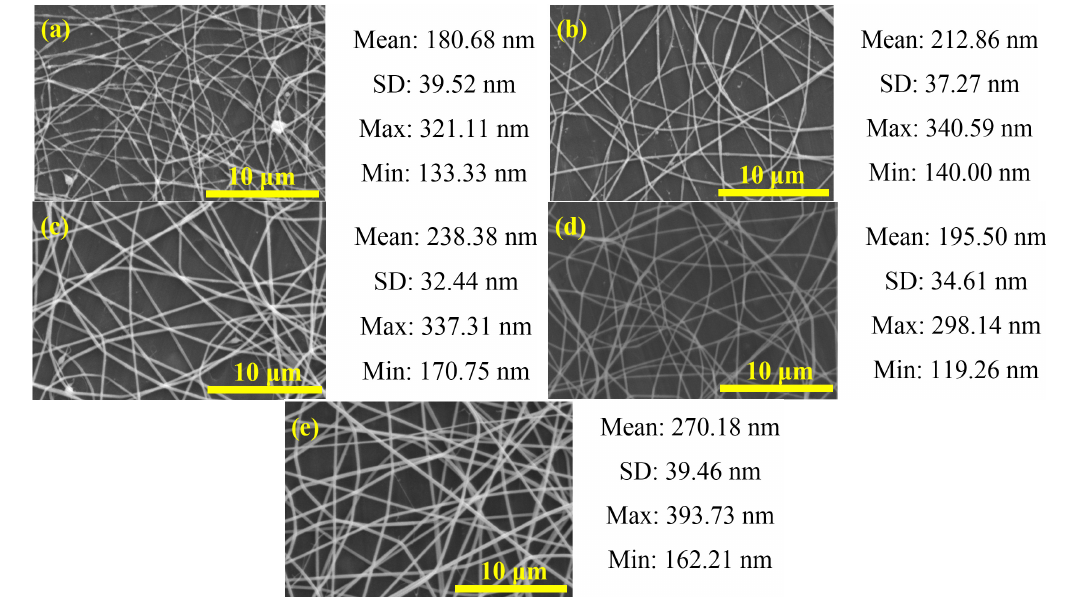
Figure 2. The changes in viscosity of PbI 2 /PVP precursor solutions with its concentration.